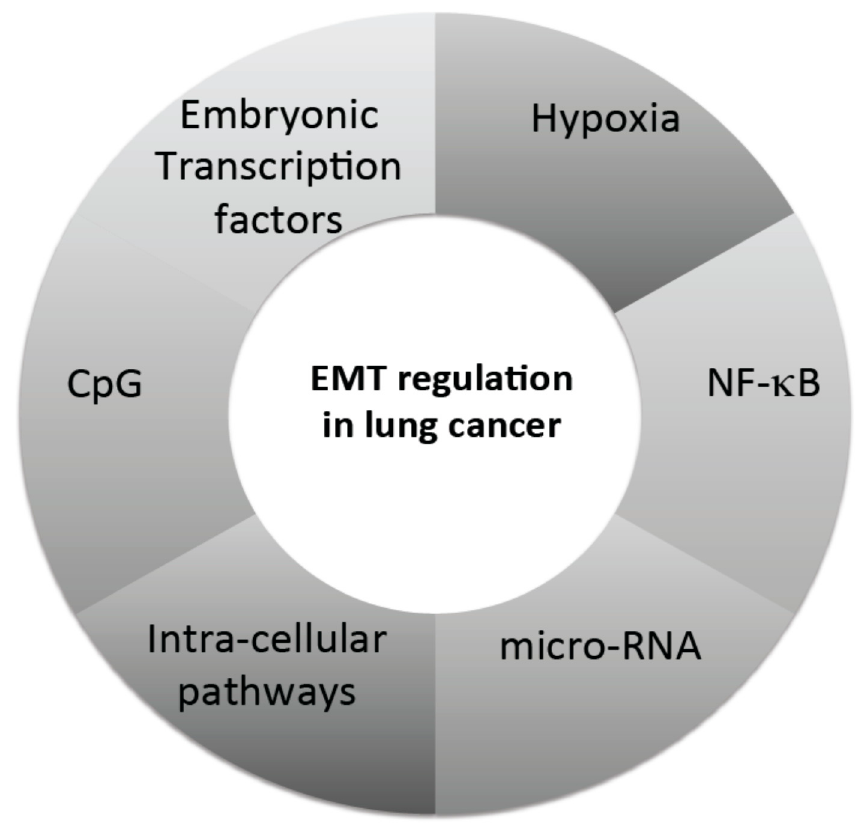
Figure 2. Hallmarks of the complex regulation of EMT in NSCLC. The regulation of EMT in NSCLC is based on several intricate conditions and actors, detailed in the Section 4 (adapted from [24,44,111,116,148,191,202,206,207,216,220,221]).